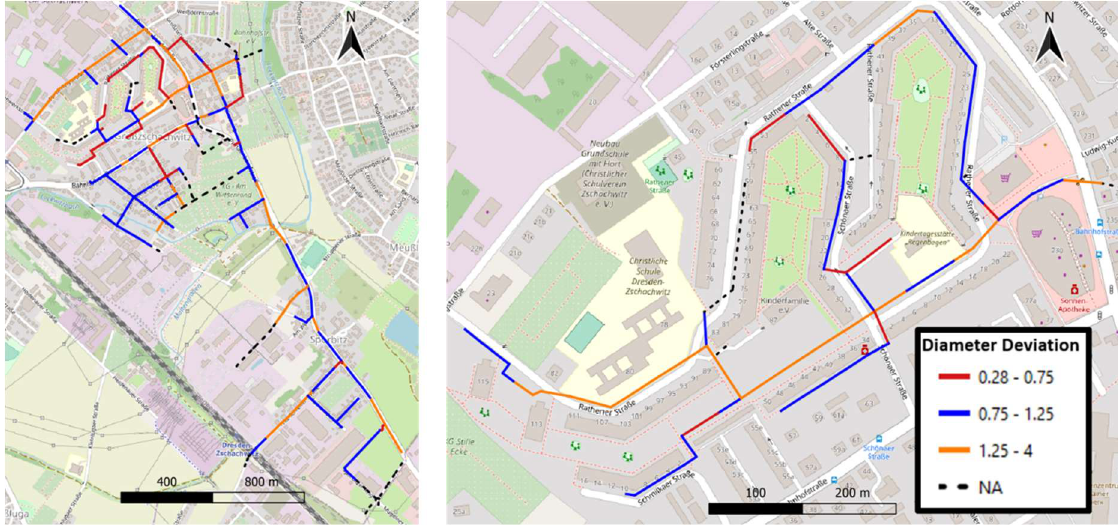
Figure 4. Comparison of simulated and real diamaters.